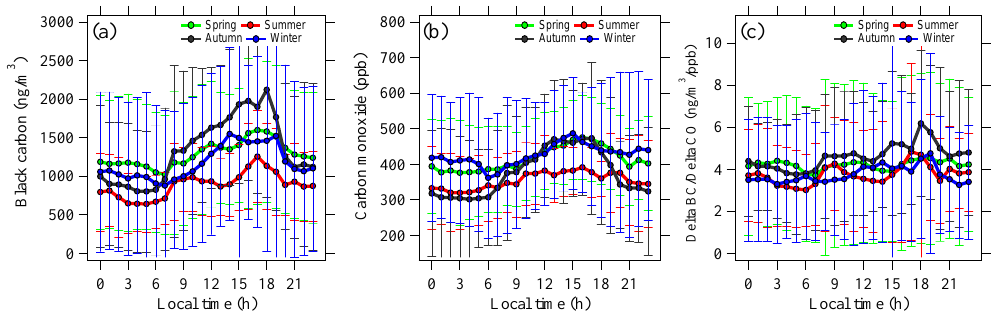
Fig. 3. Diurnal variations of BC, CO and 1 BC/ 1 CO for spring, summer, fall and winter time. In the plot, only data with RH less than 40% at observation site are taken into considerations. Spring comprises March, April and May; summer comprises June, July and August;